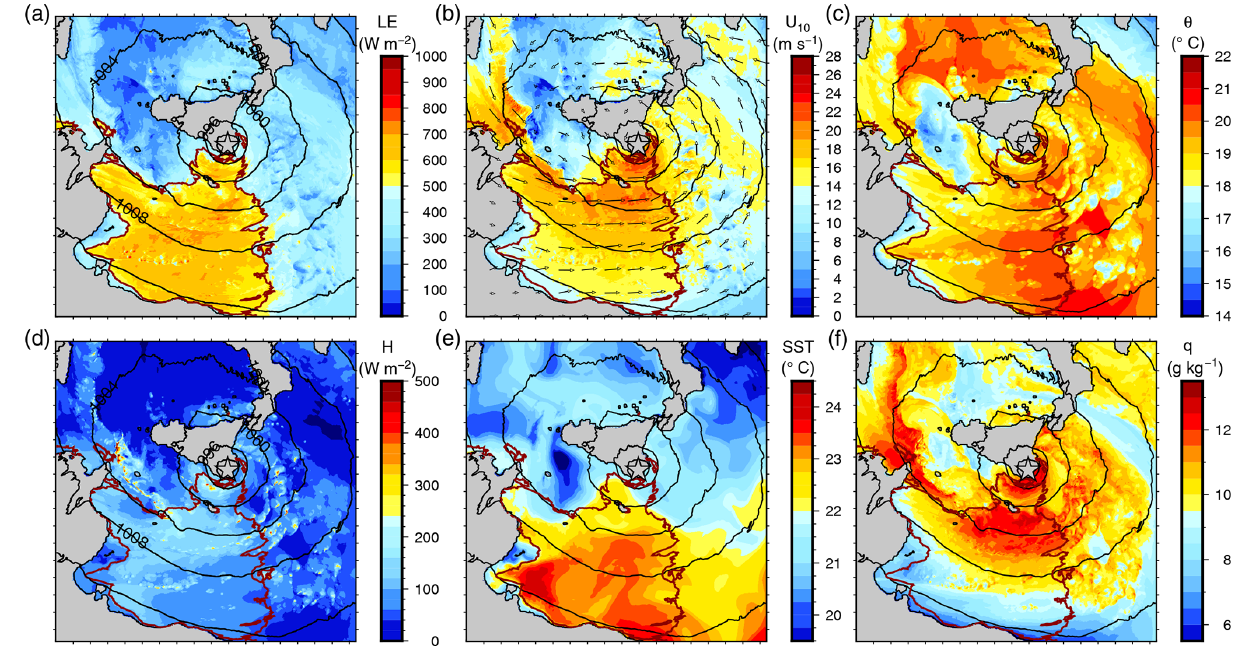
Figure 18. Same as Fig. 13 but at 18:00UTC on 7 November.